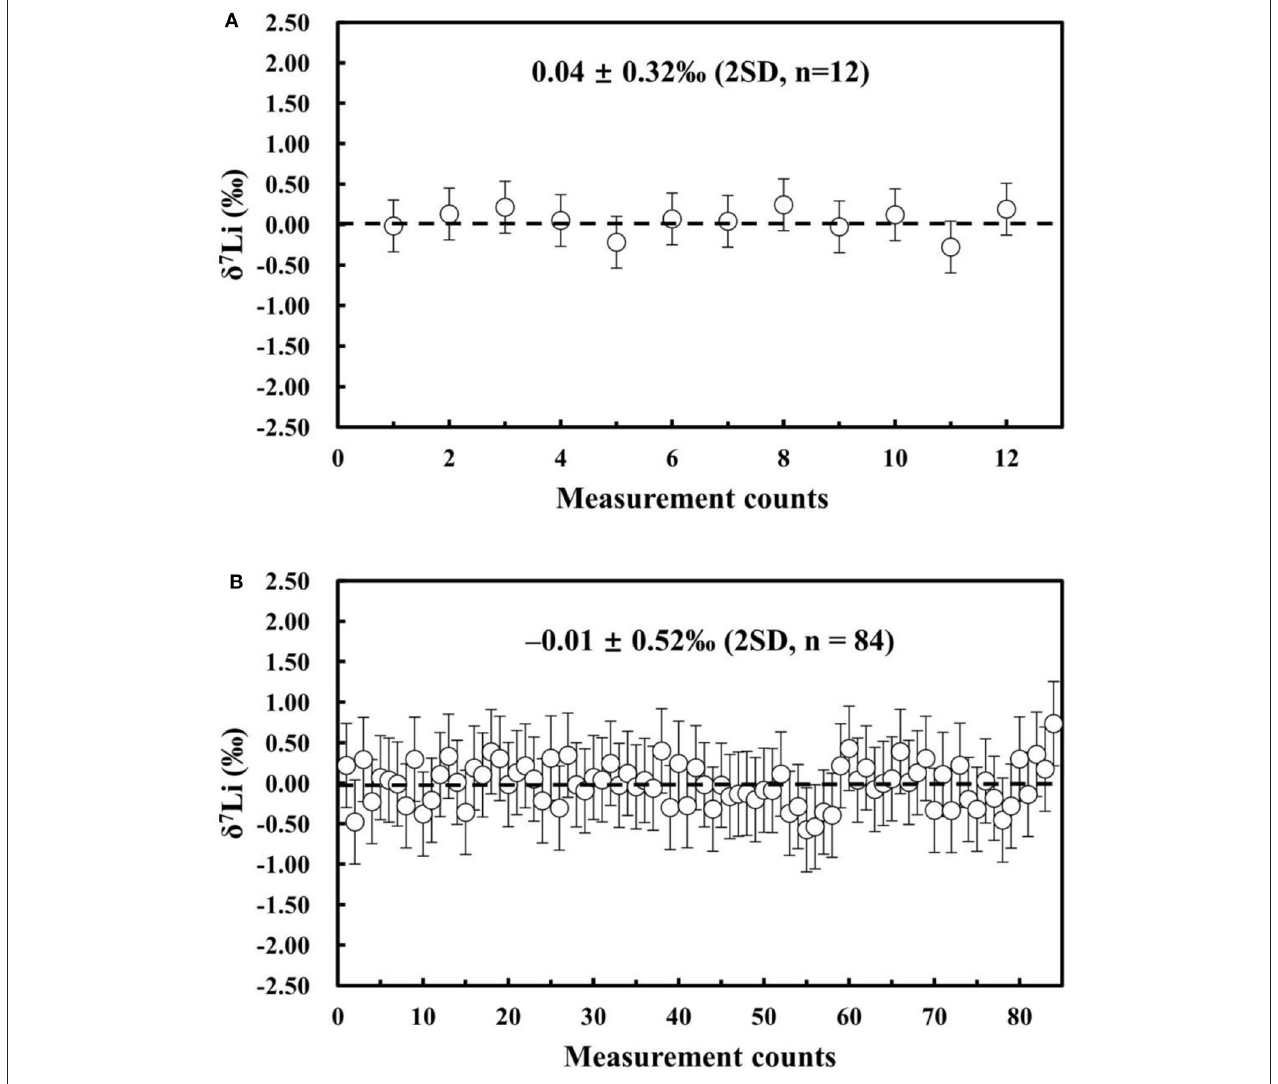
FIGURE 8 | (A) Instrument stability of 10h ( δ 7 Li of NIST L-SVEC) and (B) long-term external reproducibility for δ 7 Li (NIST L-SVEC) in the past 12 ∼